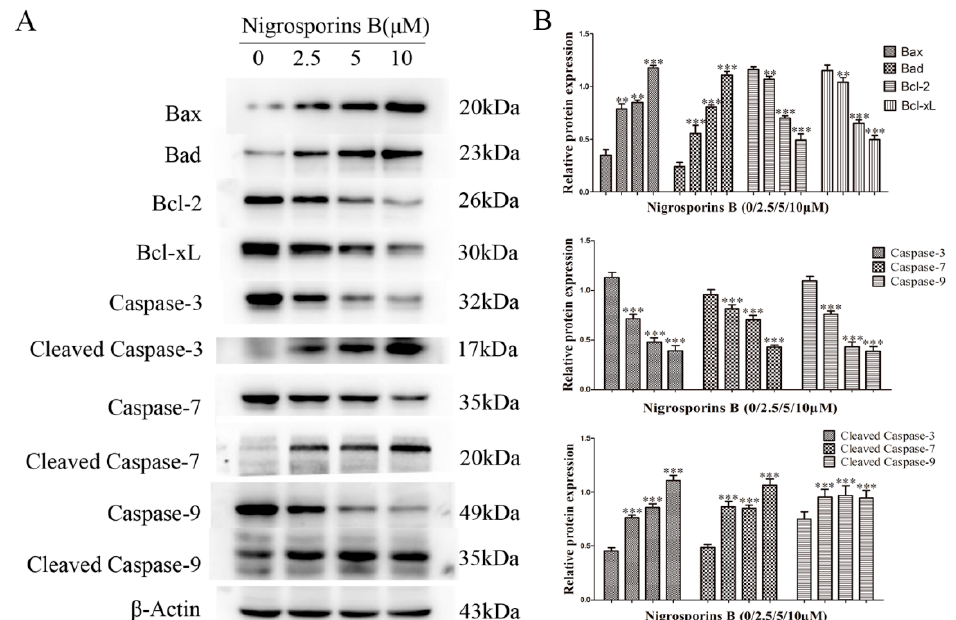
Figure 5. Nigrosporins B affected the expression of apoptosis-related proteins in Ca Ski cells, cells were treated with Nigrosporins B for 24 h. ( A ) Representative western blotting bands of Bad, Bax, Bcl-2, Bcl-xL, Caspase-3, -7 and -9 and Cleaved Caspase-3, -7 and -9 in Ca Ski cells; ( B ) Protein expression of Bad, Bax, Bcl-2, Bcl-xL, Caspase-3, -7 and -9 and Cleaved Caspase-3, -7 and -9 (** p < 0.01, *** p < 0.001).